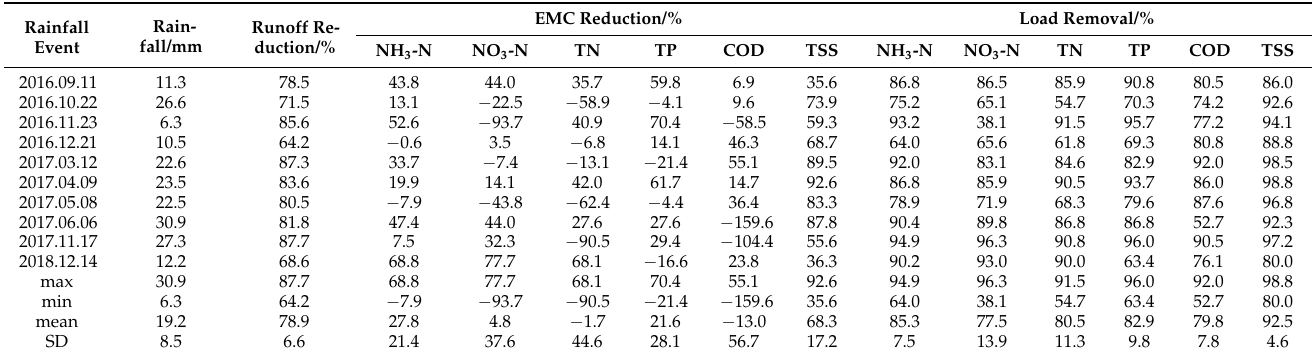
Table 2. Runoff reduction and pollutant removal efficiency data for every rainfall